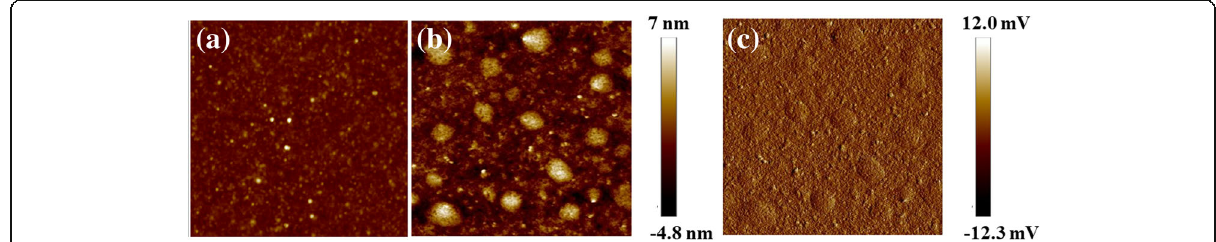
Fig. 3 PF-NR 2 AFM surface morphology a , b height images without and with Au NPs and c phase image with Au NPs (scan area 1.0 μ m × 1.0 μ m)